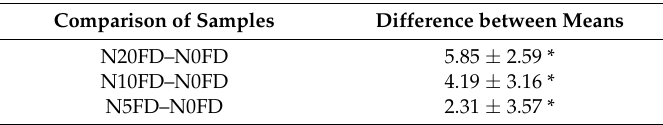
Table 2. Results of the difference-from-control test.